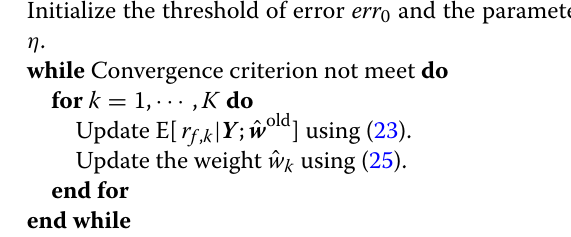
Algorithm 2 The EM